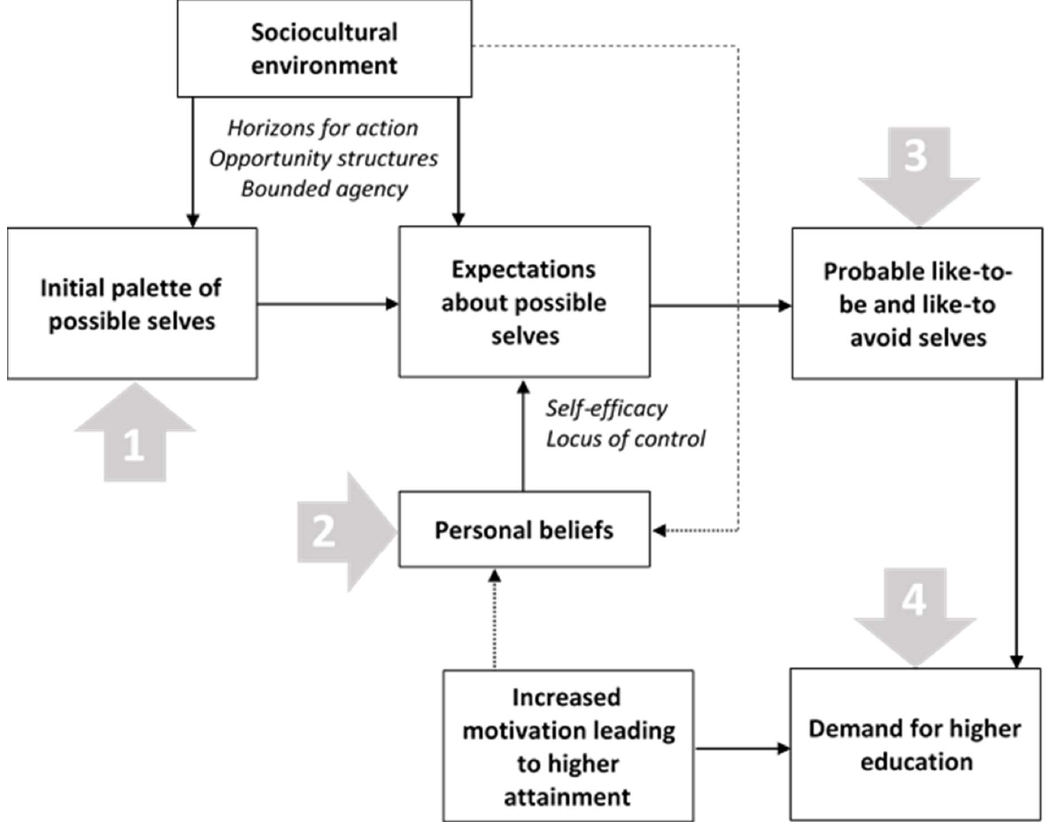
Figure 2. Proposed conceptual model (grey arrows denote possible points for planned interventions).